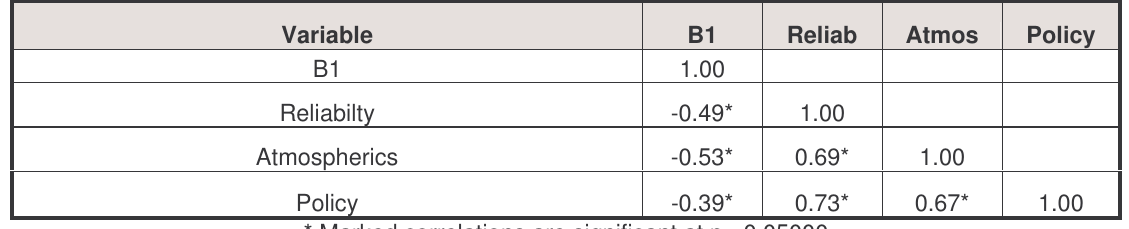
Table 4: Correlation of Overall Service Quality and Service Quality Dimensions Variable B1 Reliab